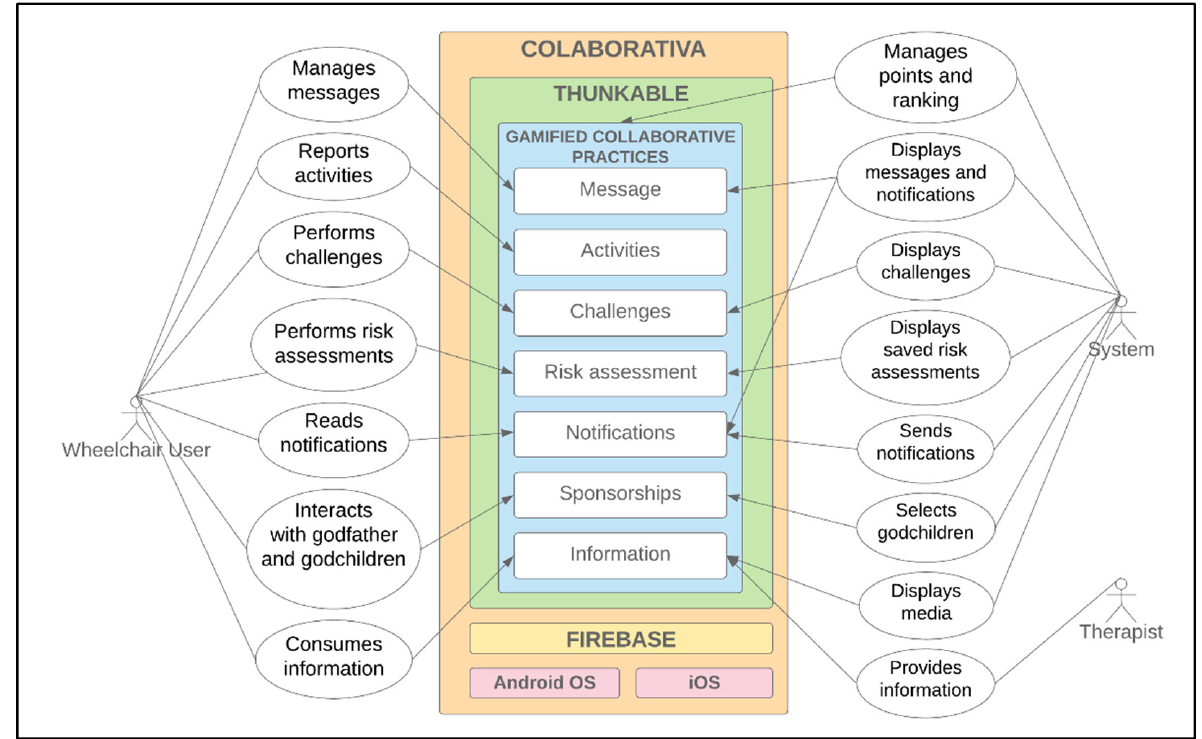
Figure 2. ColaborAtiva architecture.